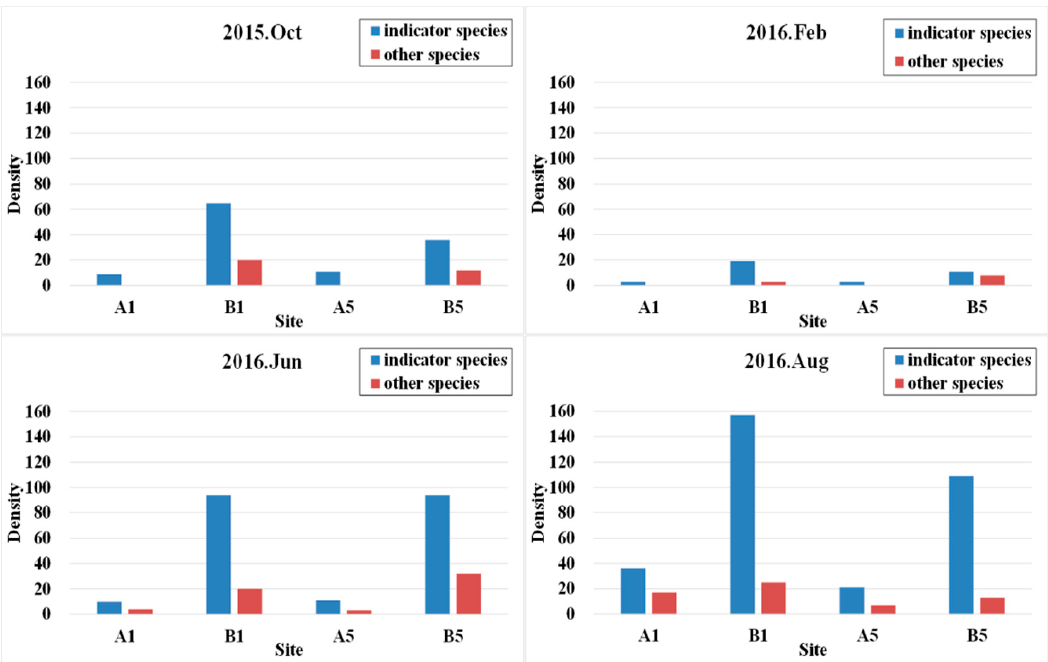
Figure 3. Densities of indicator species and other species at four sites, A1, B1, A5, and B5, in October 2015 and February, June, and August 2016.